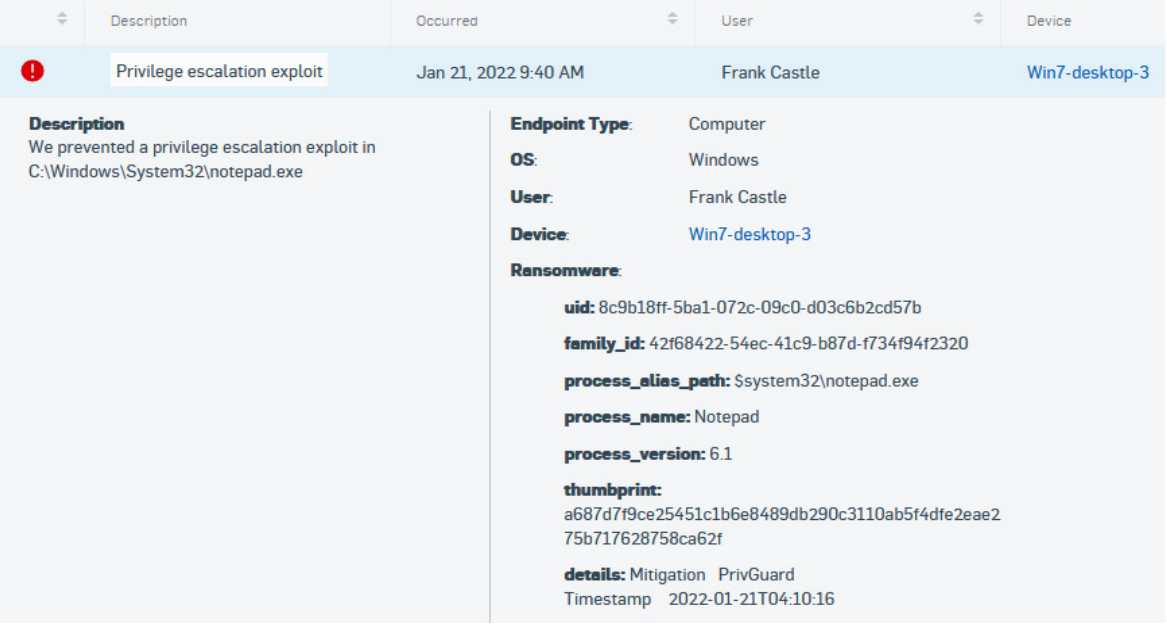
Figure 18. Privilege escalation identified.